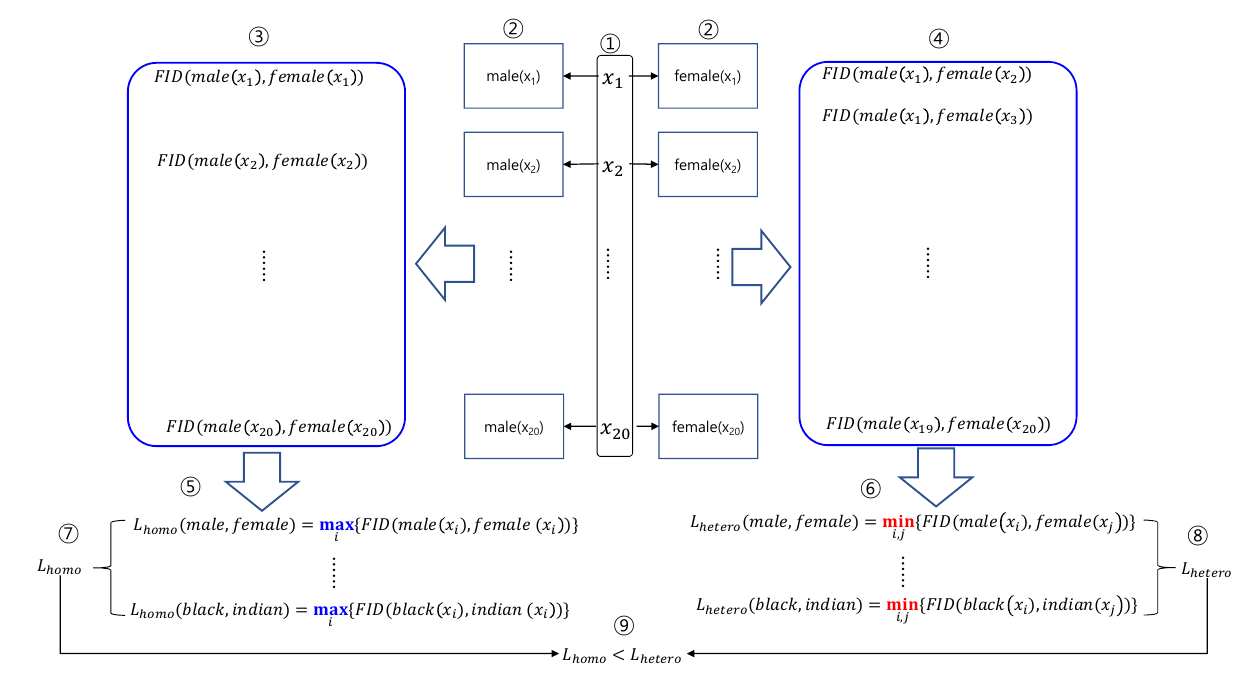
Figure 7. Process of measuring the preservation of